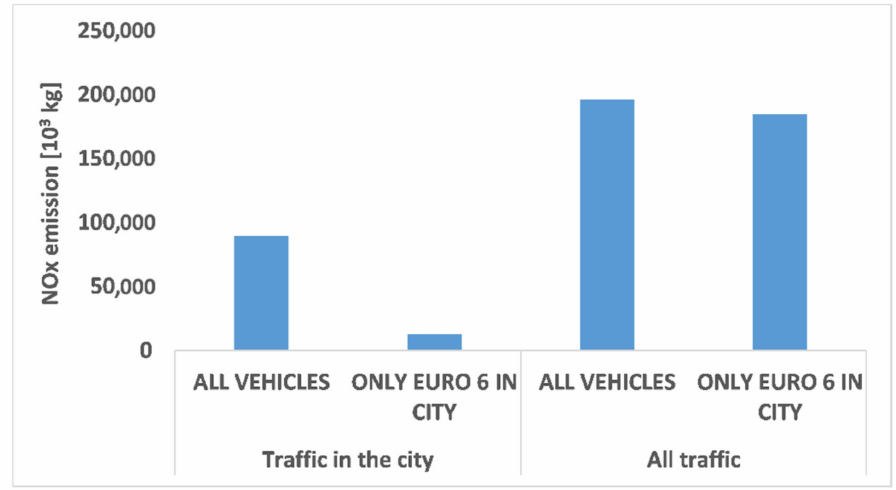
Figure 20. Comparison of NO X emissions from all vehicles and Euro 6 vehicles only in an urban